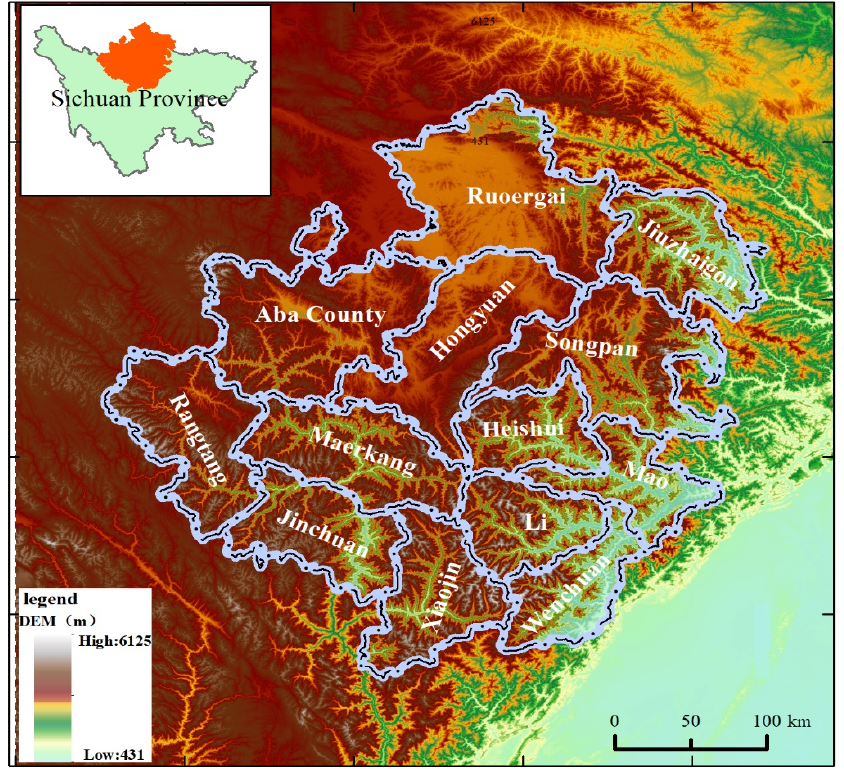
Figure 1. Aba Location Map.